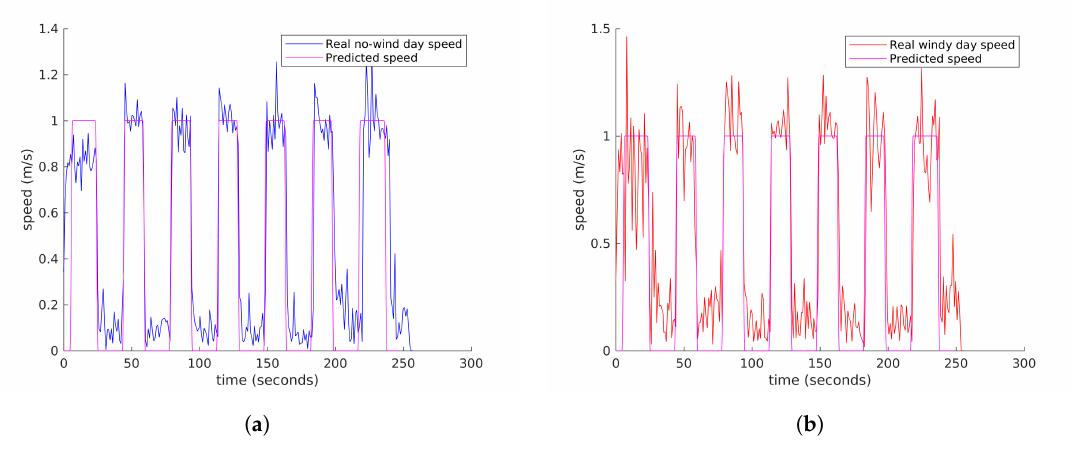
Figure 17. Comparison of groundspeed between normal conditions and a day of strong wind. ( a ) Low wind real and MDS predicted groundspeed; ( b ) Strong wind real and MDS predicted groundspeed. The photographs taken by the drone at the mission waypoints during actual flight execution can be seen in Figure